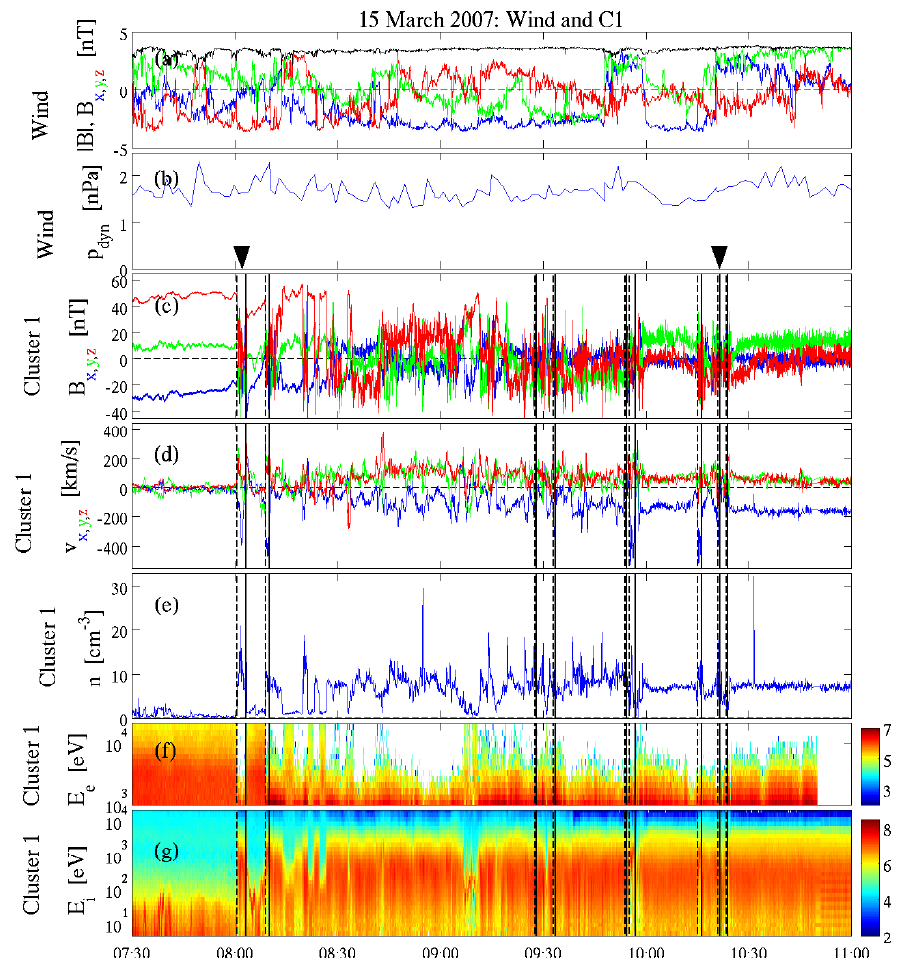
Figure 5. Data obtained by the Wind and Cluster 1 spacecraft on 15 March 2007. (a) Solar wind magnetic field B x (blue), B y (green), B z (red), and | B | (black); and (b) solar wind dynamic pressure, both measured by the Wind spacecraft. Panels (c–g) show data from Cluster 1. (c) Magnetic field B x (blue), B y (green), and B z (red); (d) ion velocity v x (blue), v y (green), and v z (red); (e) ion density; (f) electron energy spectrum above 1keV, with the colour coded scale showing the logarithm of the omnidirectional differential particle flux in units of cm − 2 s − 1 sr − 1 keV − 1 ; and (g) the ion energy spectrum, where the colour scale shows the logarithm of the omnidirectional differential particle flux, in units of cm − 2 s − 1 sr − 1 keV − 1 . The components of the vector quantities in panels (a) , (c) , and (d) are shown in GSE coordinates. The vertical lines mark the plasmoids that have been identified in Table 1. The first and the next to last plasmoids (marked by downward pointing black triangles above panel c ) are discussed in the text, and they are shown on a larger scale in Figs. 6 and